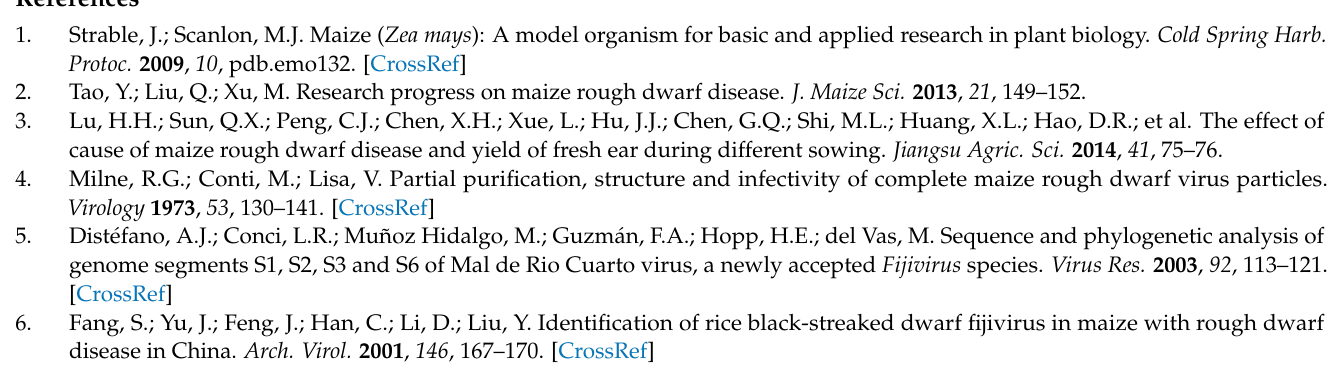
Figure S2: Scanning electron micrograph of adaxial surface of leaves of RBSDV-infected B73, Mock- B73, RBSDV-infected X178 and Mock-X178; Table S1: Differentially expressed proteins (DEPs) identi- fied in RBSDV-infected B73; Table S2: DEPs identified in RBSDV-infected X178; Table S3: Common DEPs identified in RBSDV-infected B73 and